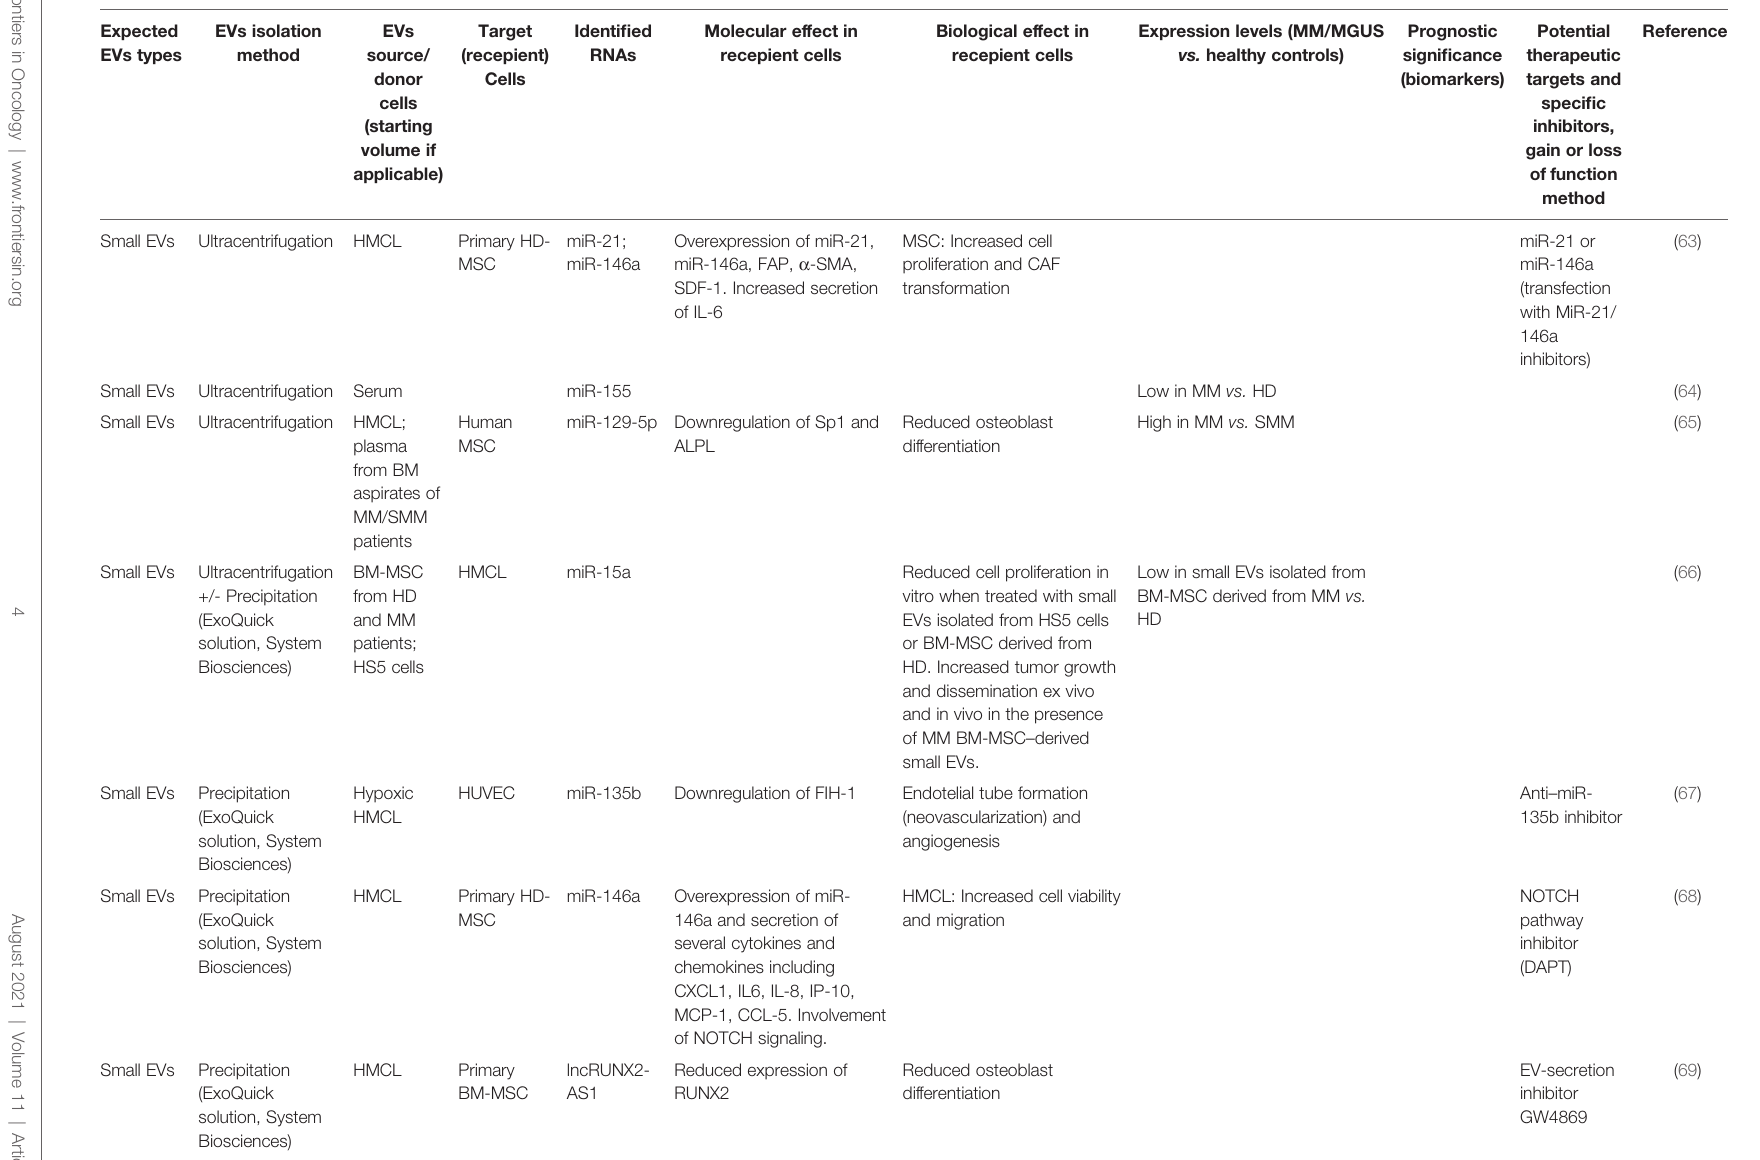
TABLE 1 | Summary of fi ndings on the role of EV-RNAs in MM pathobiology and as clinical